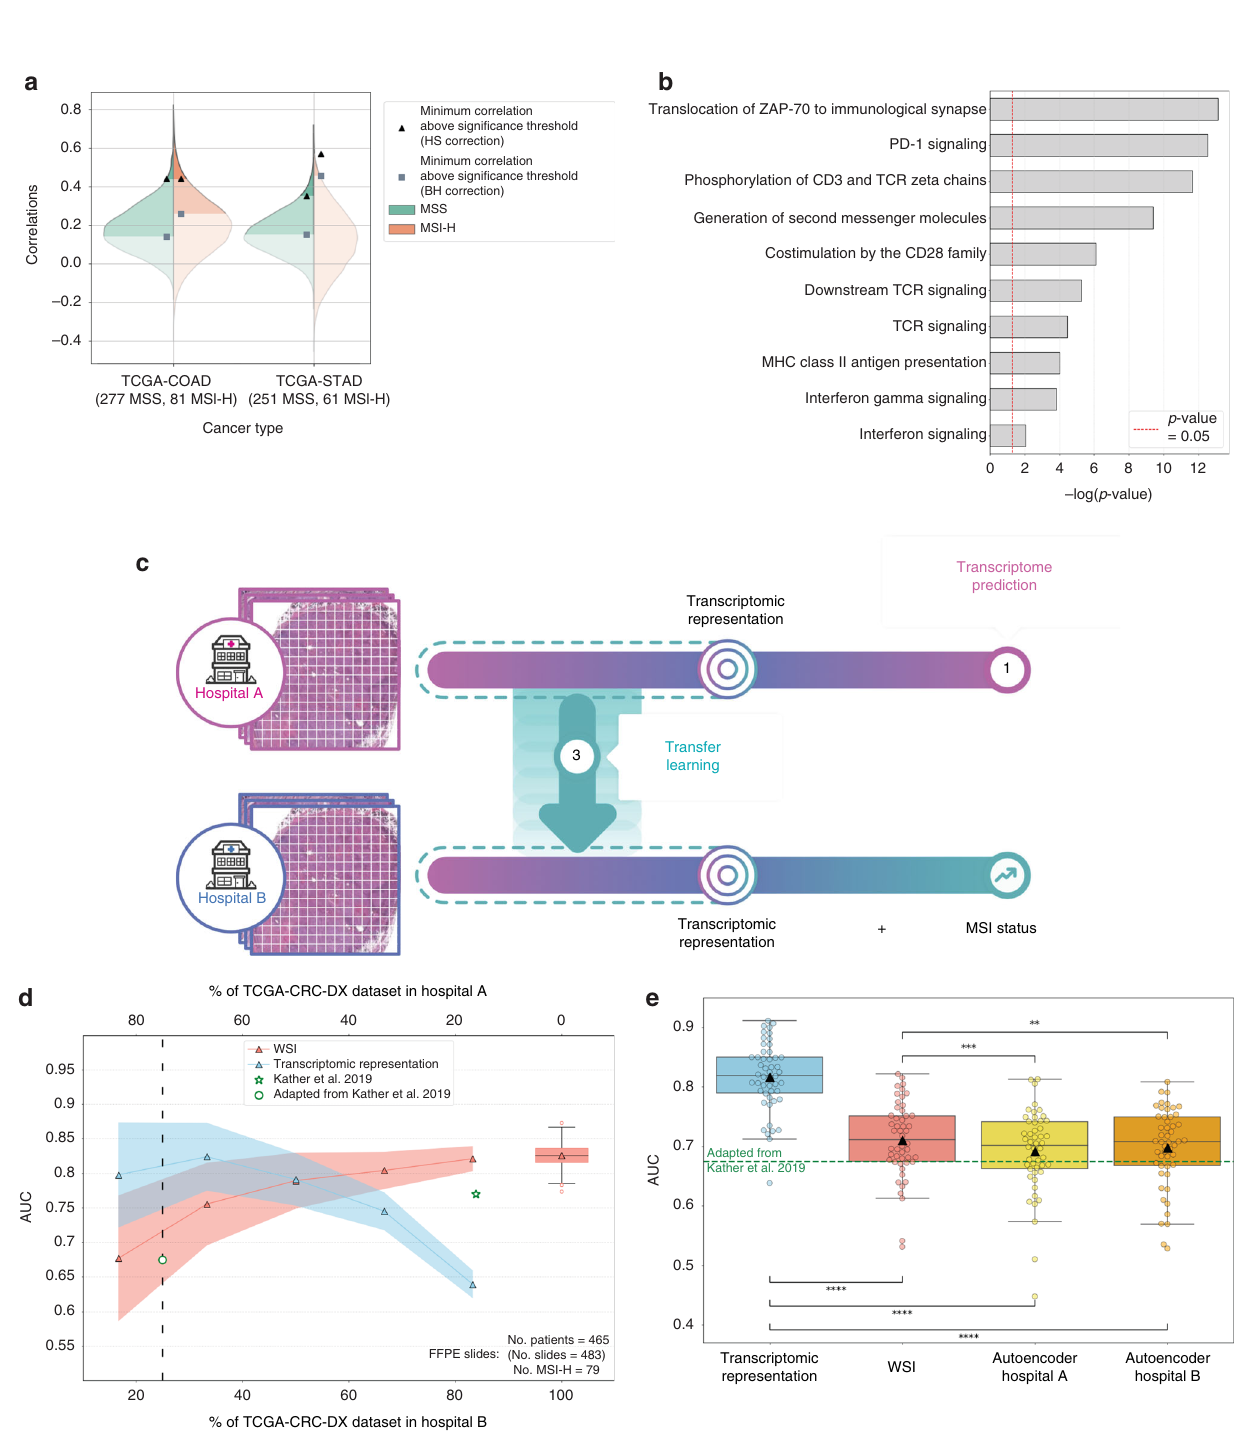
No. patients = 465 FFPE slides: (No. slides = 483) No. MSI-H =